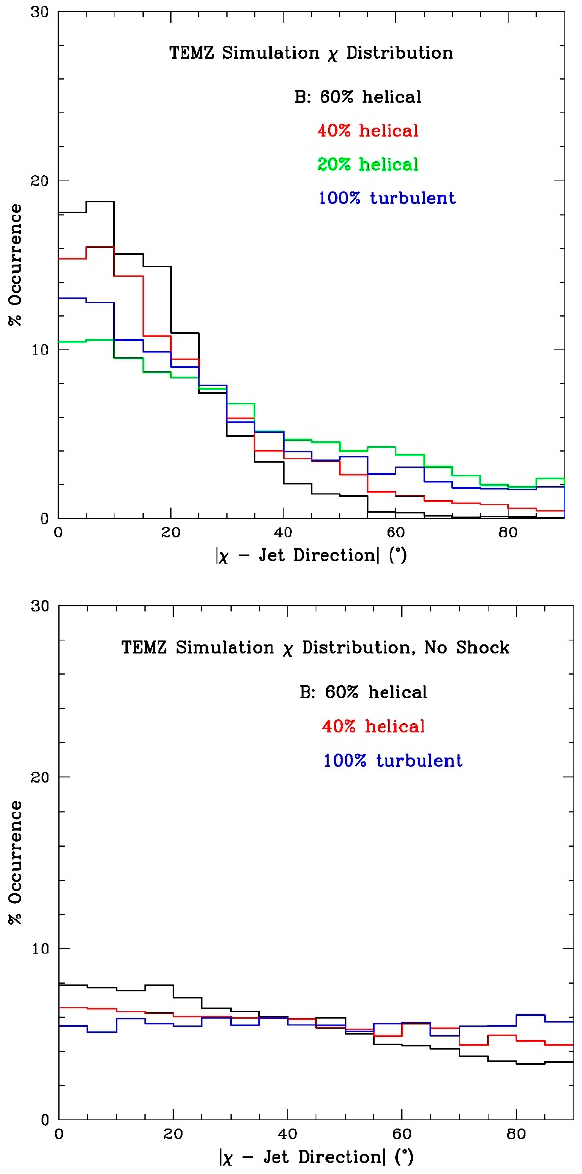
Figure 4. Histograms of the distribution of χ (I) relative to the jet direction from the same TEMZ simulations as in Figures 2 and 3. Left panel: turbulent jet with a standing conical shock. Right panel: turbulent jet without a shock.